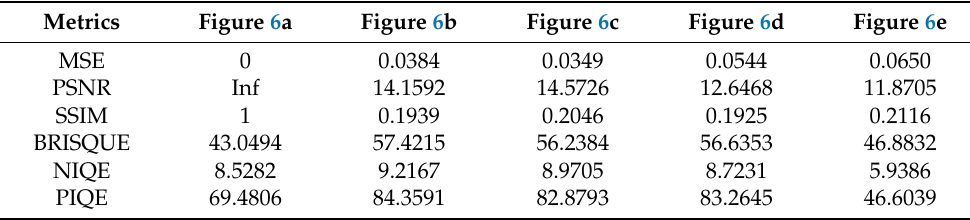
Table 1. The results of the accuracy evaluation of coherent